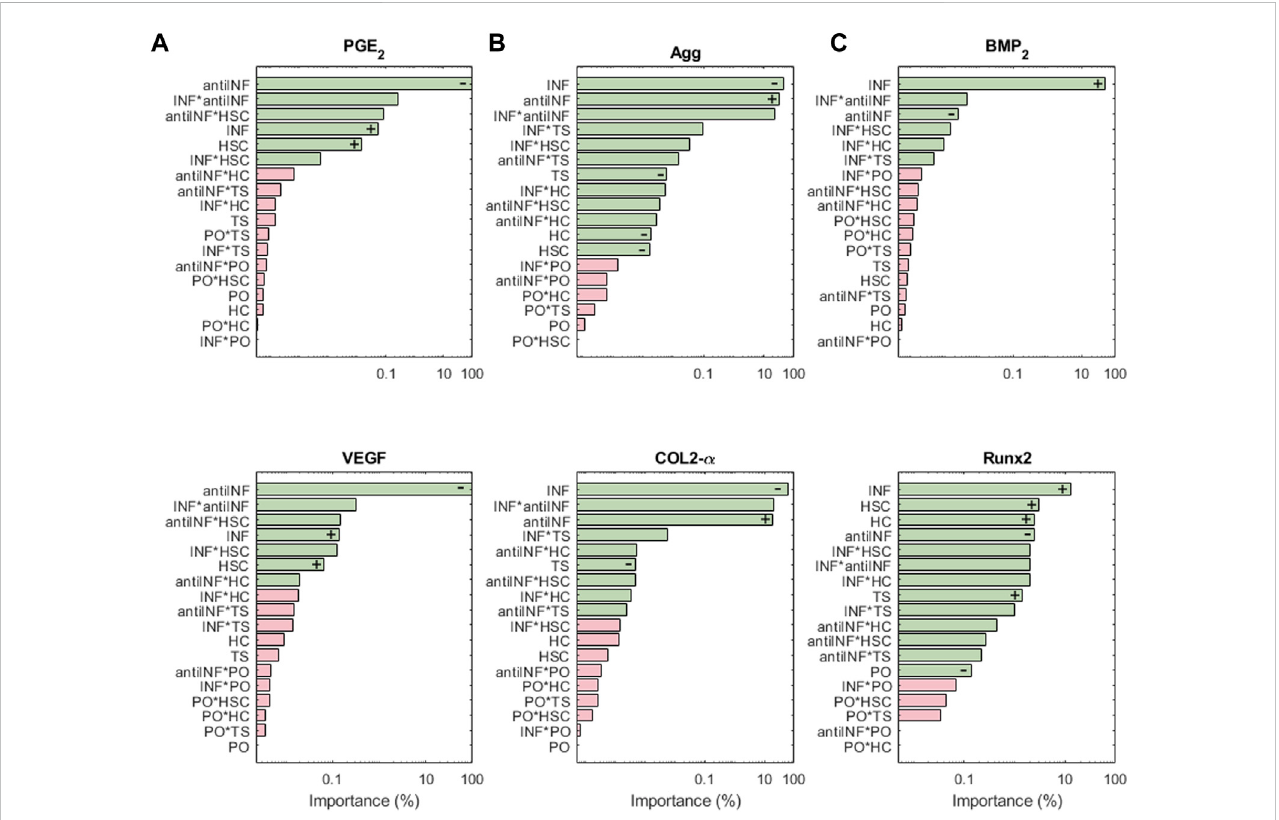
FIGURE 8 Theresultsofthesensitiviyanalysisforpainrelatednodes (A) ,structuralproteins (B) ,andhypertrophymarkers (C)